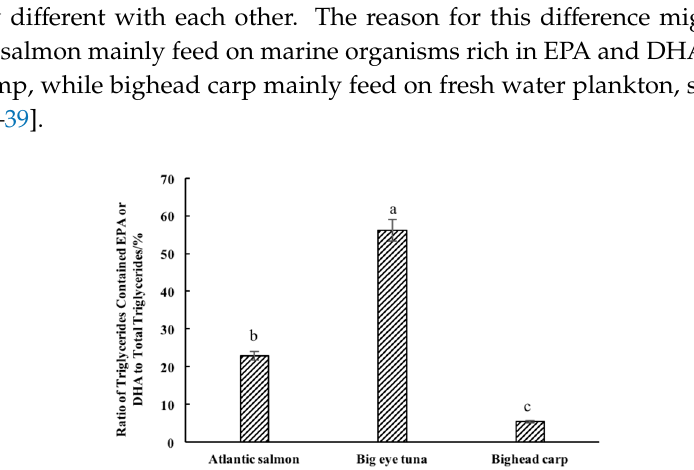
As listed in Table S3, TG (16:0 / 18:1 / 18:1) (14067.04 ng / µ L, 3.14%), TG (16:0 / 18:1 / 22:6) (24375.98 ng / µ L,